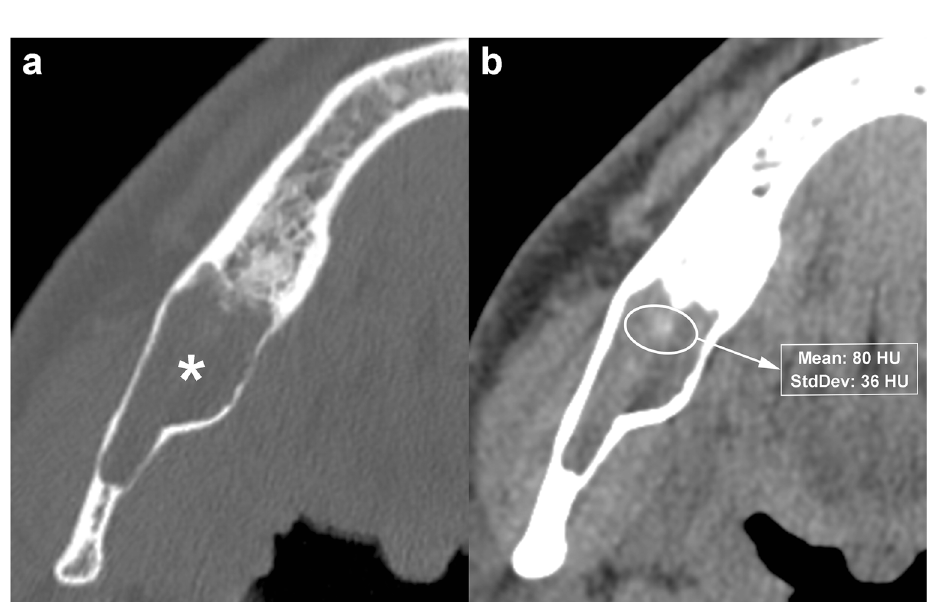
Fig. 12 Axial MDCT image with bone window ( a ) shows an OKC in the posterior region of the right mandible ( asterisk ). Axial MDCT image with soft tissue window ( b ) clearly demonstrates a high- density area within the mandibular lesion ( ellipse ROI ) with a mean attenuation value of 80